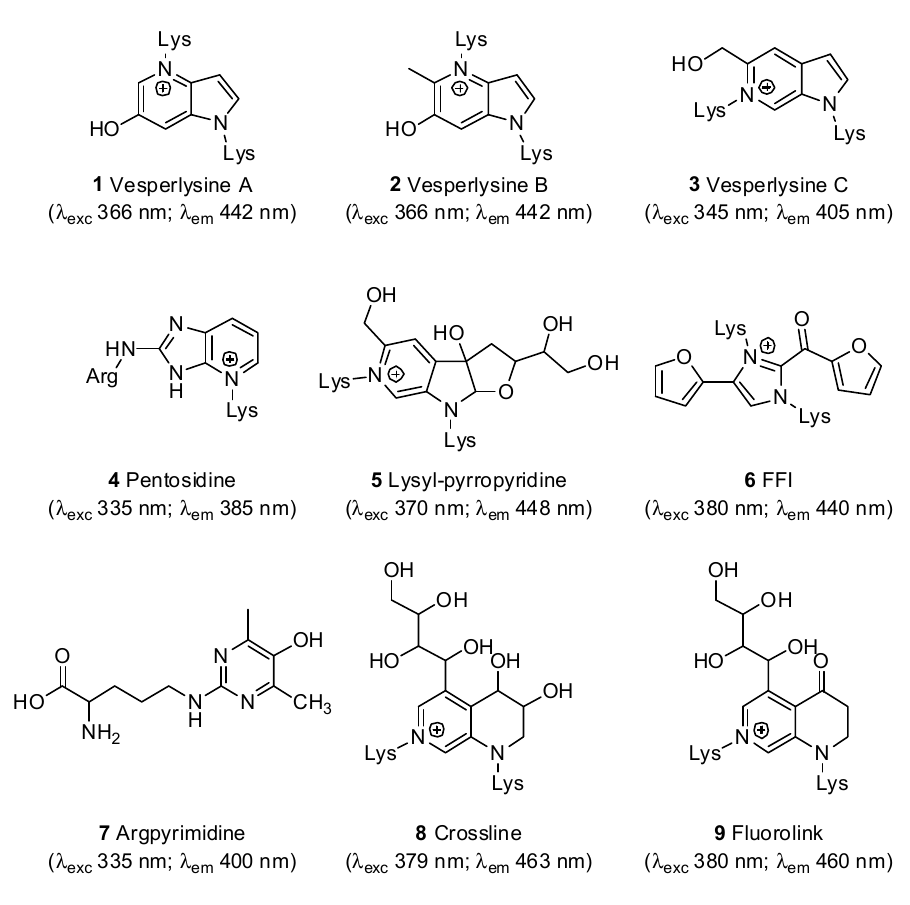
Figure 1. Structures of the main fluorescent AGEs 1 – 9 and their fluorescent properties in neutral aqueous media